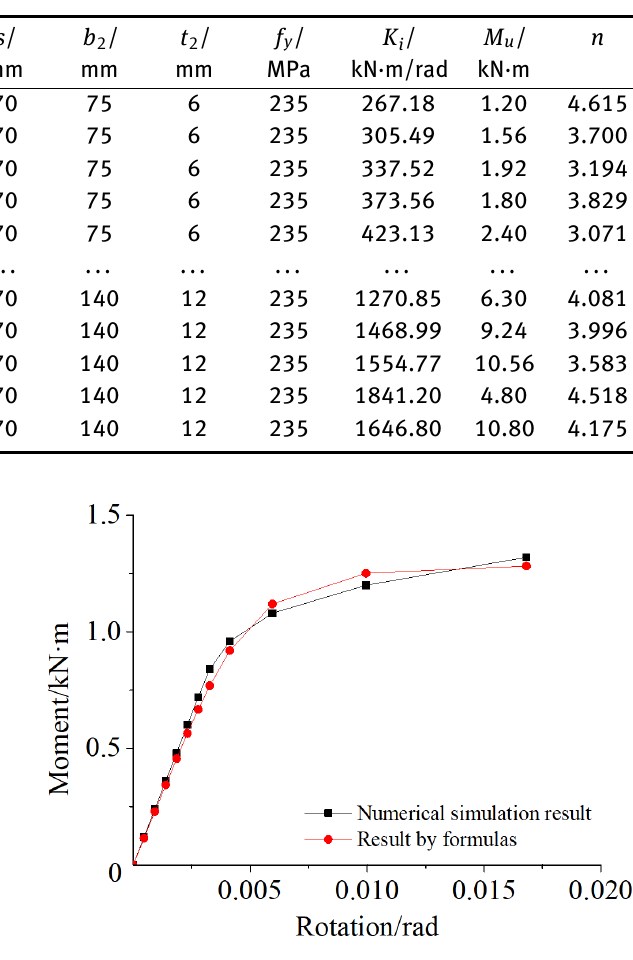
Table 2: Parameters and calculation results of angle joint models